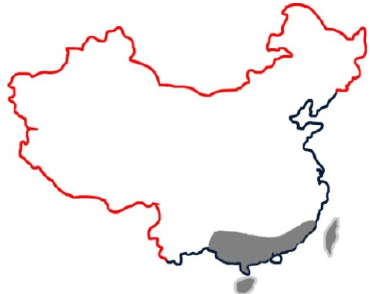
Figure 36. Hot summer and mild winter region